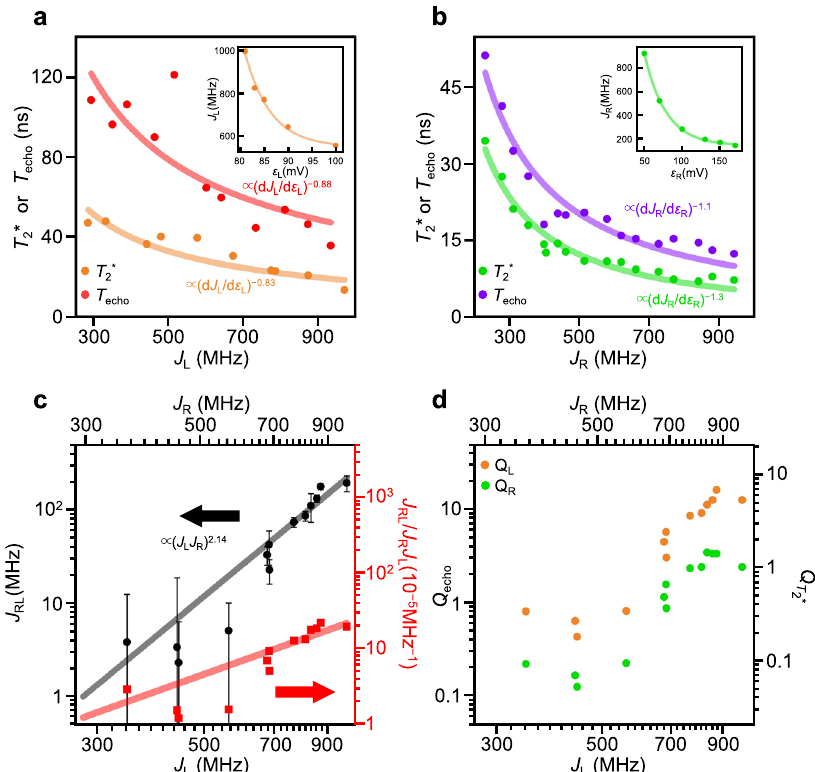
Fig. 4 Super-linearly increasing the inter-qubit coupling strength. a , b T 2 * and T echo of Q L (Q R ). The solid curves are fi t to the forms dJ = d ε ð Þ (cid:4) b with best fi t parameter b (cid:2) 1.0. Inset: the intra-qubit exchange energy of each qubit as a function of detuning amplitude ε . The solid line denotes an exponential fi t of a form J ε ð Þ ¼ J 0 þ J 1 exp ε 0 (cid:4) ε ð Þ = α ð Þ . c J RL (black circle) and J RL / J L J R (red square) as a function of J L and J R . The black solid line is a fi t to J RL ¼ a J L J R ð Þ α with the best fi t parameter α = 2.14 indicating super-linear behavior. The error bars are estimated from and Q echo of Q L (orange circle) and Q R (green the fi tting uncertainty. d The conditional phase- fl ip quality factors Q T (cid:5) 2